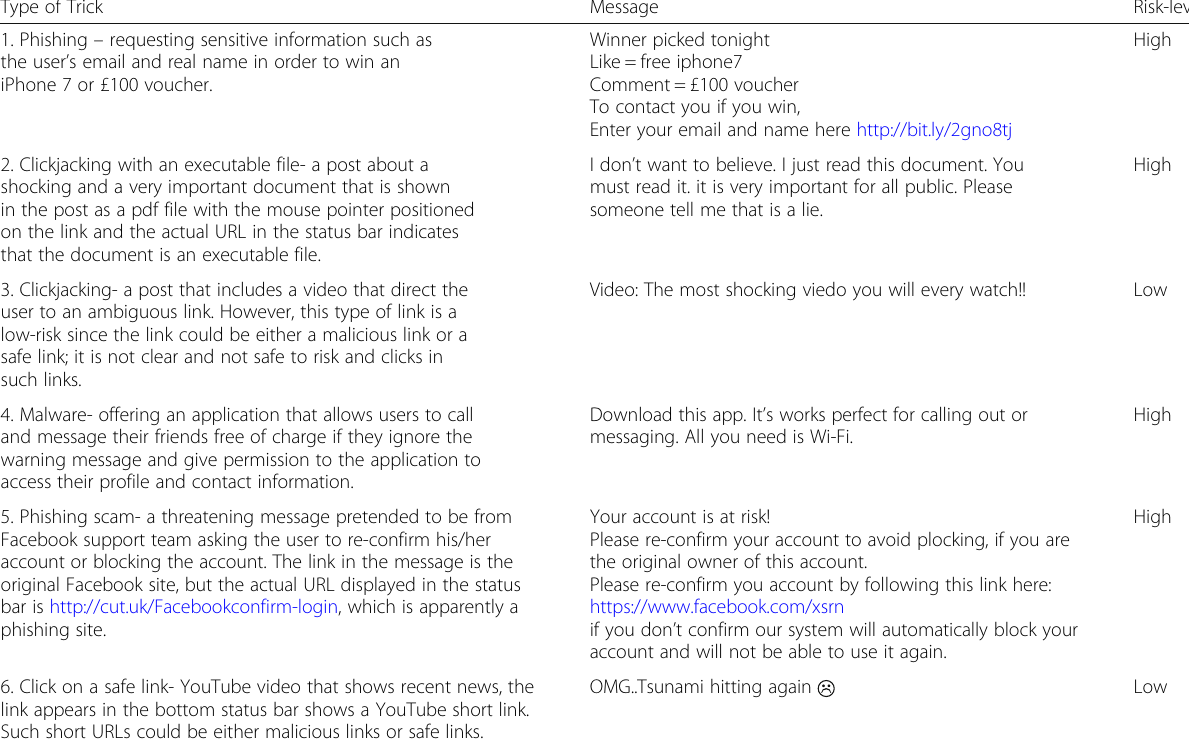
Table 12 A Summary of the social engineering